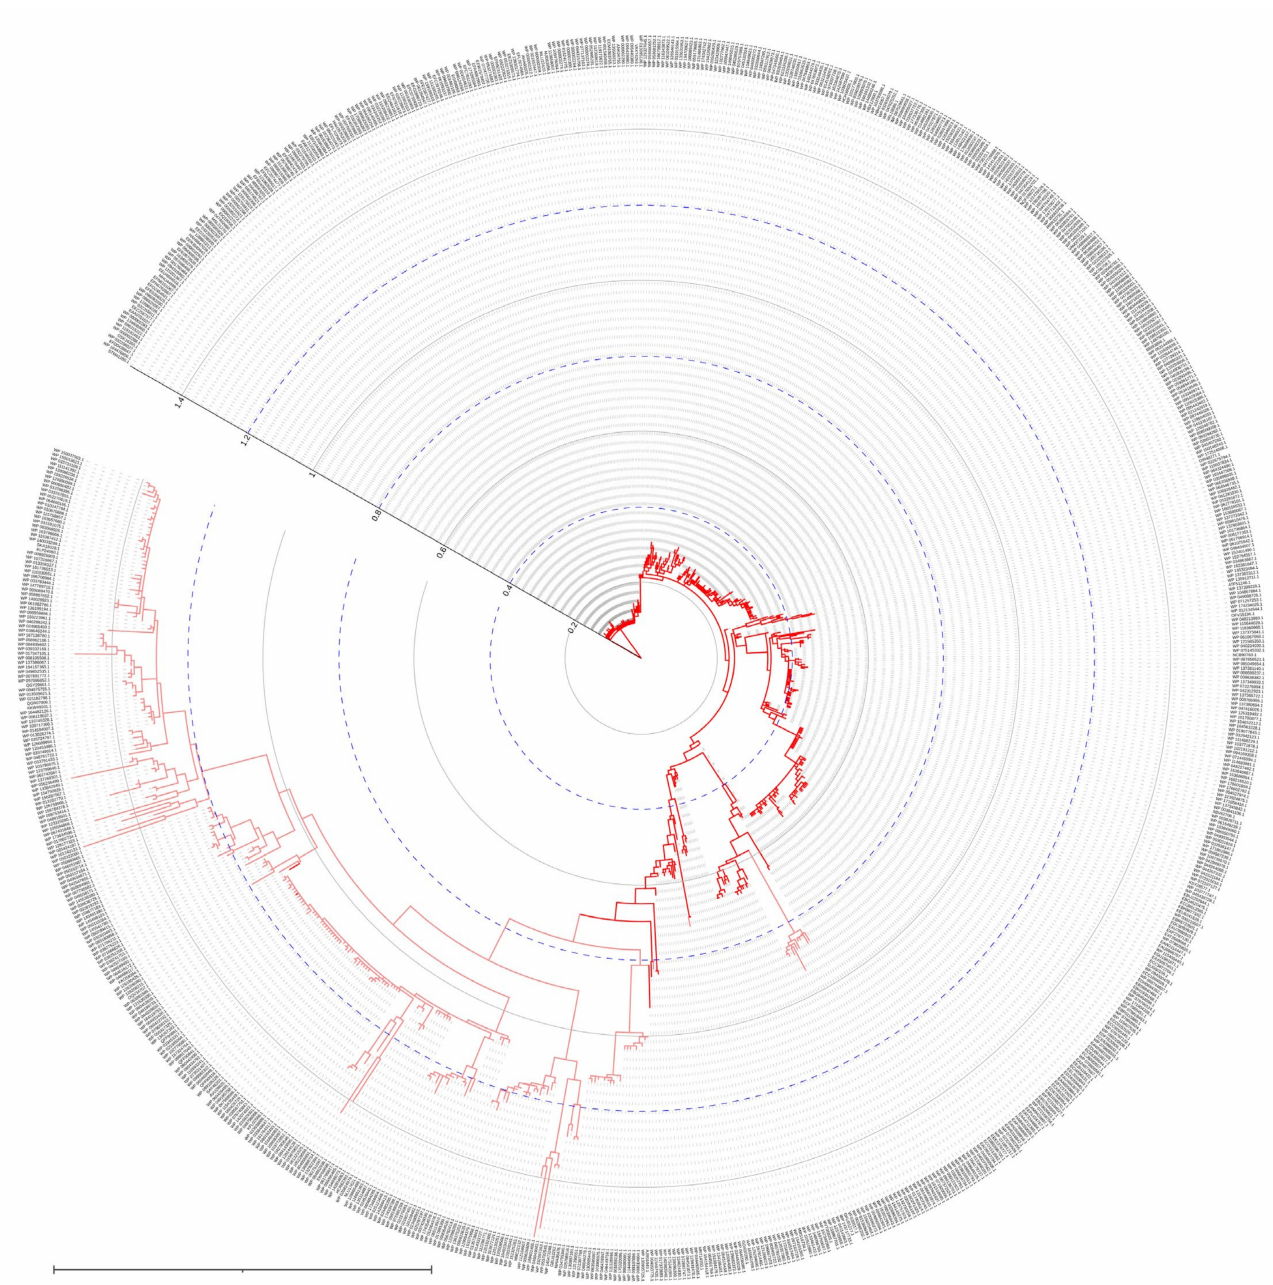
Figure 18. Phylogenetic tree of PhnJ subunit of C-P lyase and its homologous enzymes (down to 85% identity). The tree was built as previously with PDB 4XB6 as a reference sequence. Enzymes having high (90–100%) and good (80–89%) identity are highlighted with red and pink,